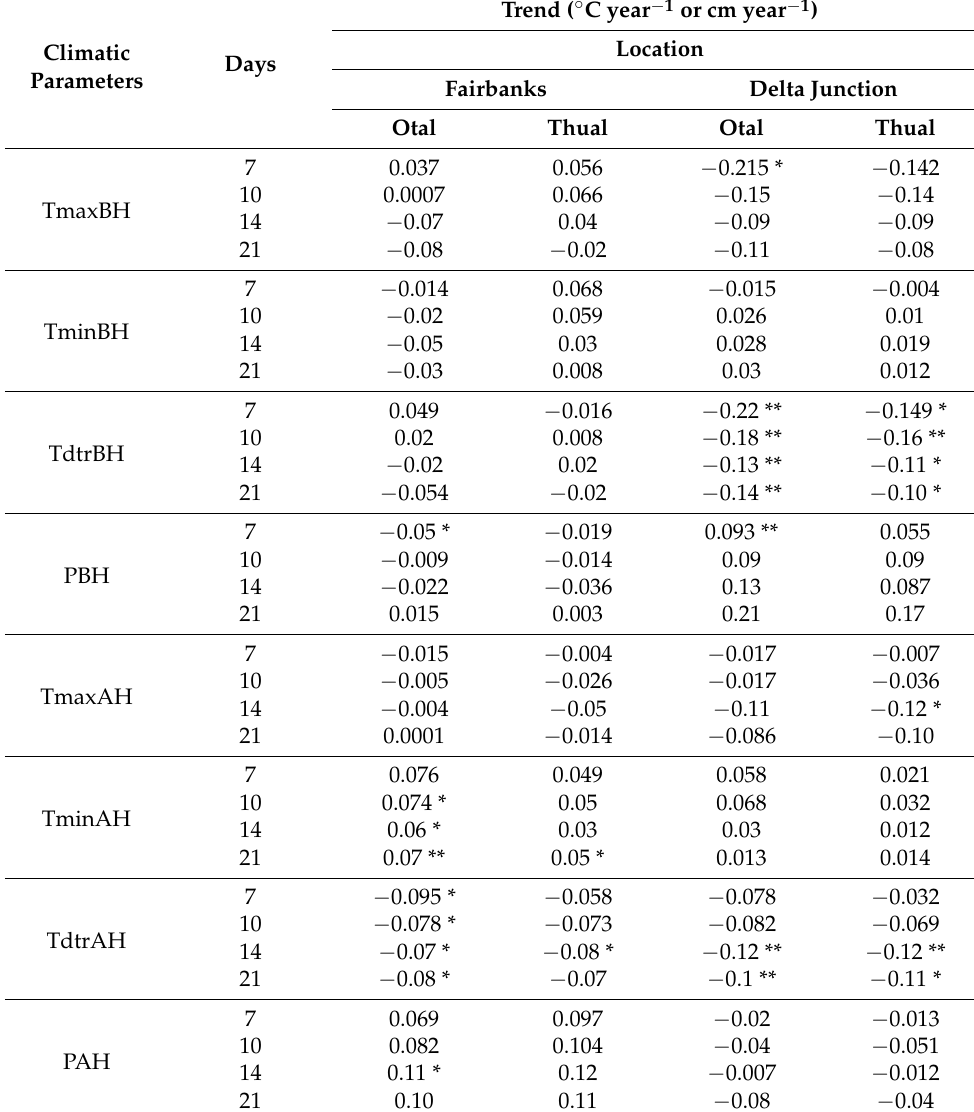
Table 1. The trends of TmaxBH, TminBH, TdtrBH, PBH, TmaxAH, TminAH, TdtrAH, and PAH at 7–21 days of ‘Otal’ and ‘Thual’ heading from 1991 to 2018 in Fairbanks and from 1992 to 2014 in Delta Junction,